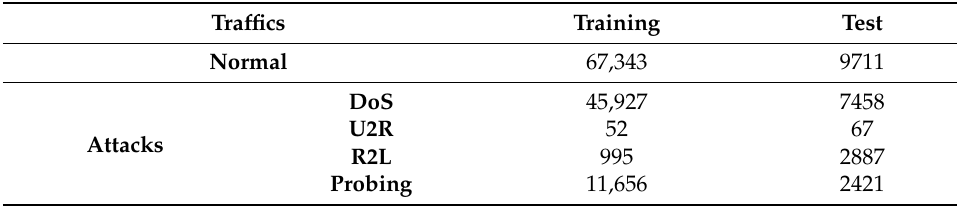
Table 2. NSL-KDD dataset.